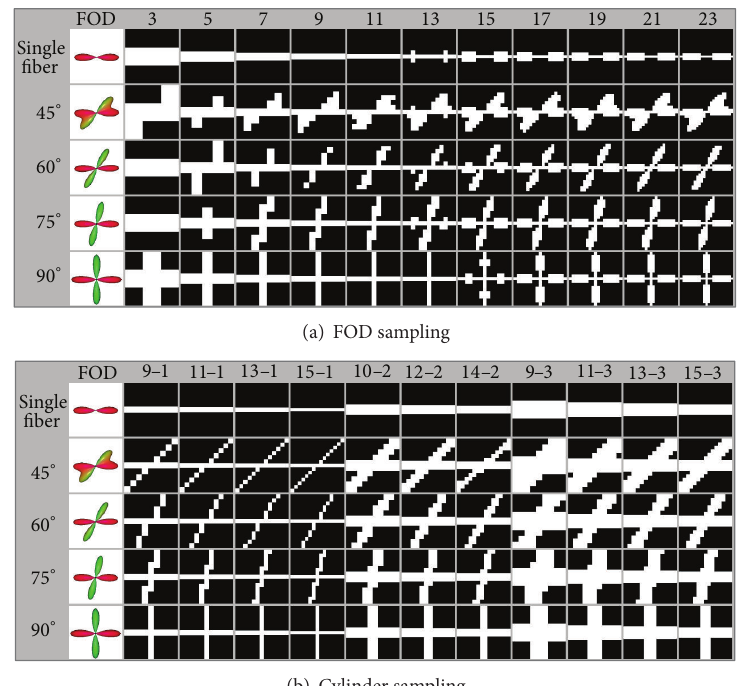
Figure 2: Glyph sampling with different anisotropy direction angles: (a) sampling of FOD glyph with sampling sizes from 3 × 3 × 3 to 23 × 23 × 23 , (b) sampling of cylindrical glyphs with sampling sizes from 9 × 9 × 9 to 15 × 15 × 15 and cylinder width from 1 to 3.